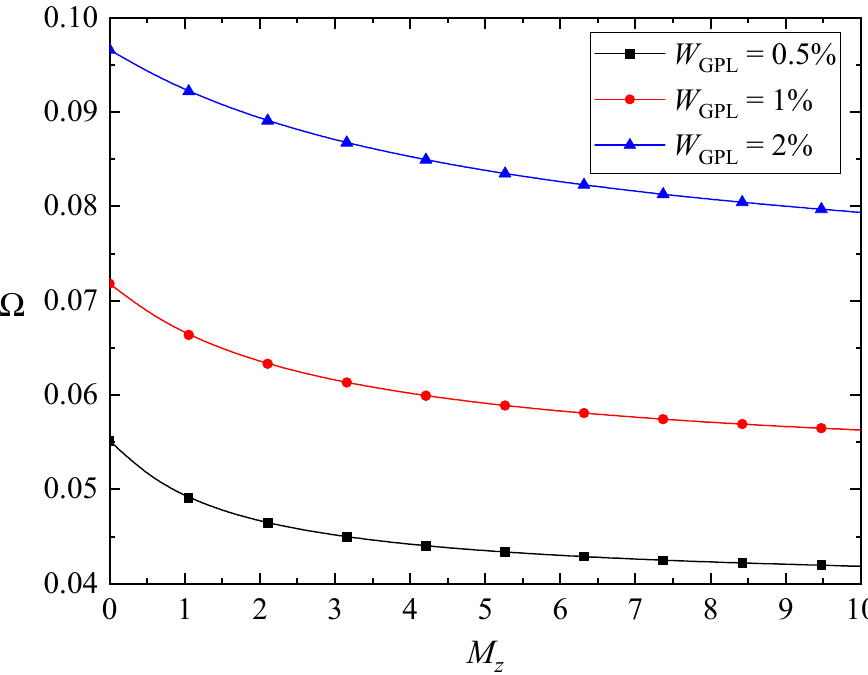
Ω with the z -direction magnetic field ( λ = 1/10, K w